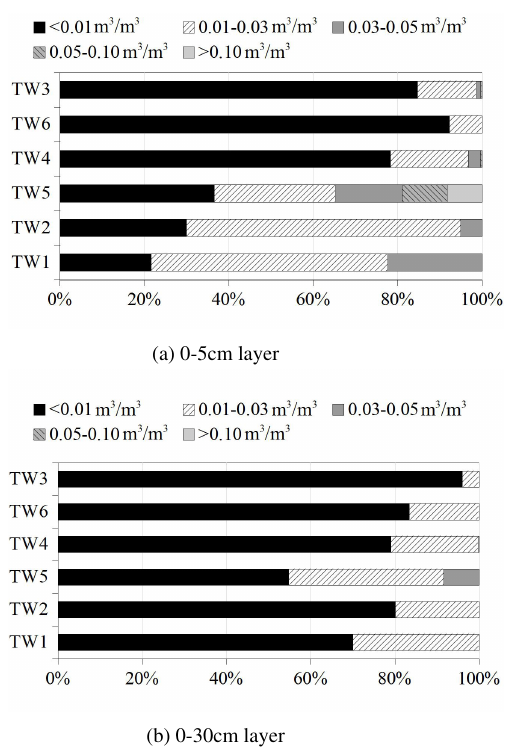
Figure 6. Absolute water content difference distribution between the developed model and TEC for each climatic case study.